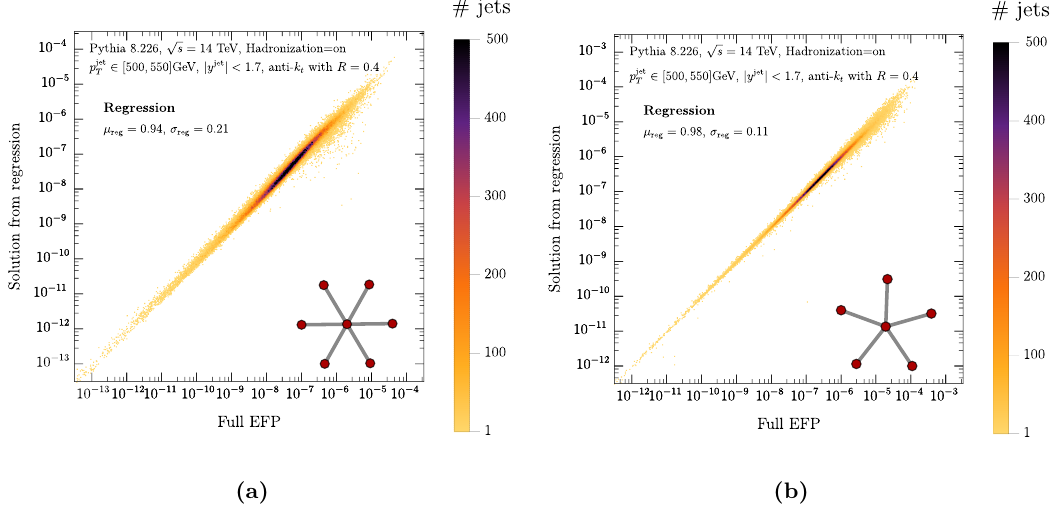
Figure 10. Testing the relationship between the 6-pointed (left) and 5-pointed (right) star EFP and a corresponding linear fit of EFPs belonging to the 2-collinear basis. The average and standard deviation of the ratio is greatly improved over that for the relationship obtained using 2-collinear power counting, which was ( µ, σ ) = (4 . 89 , 3 . 86) and ( µ, σ ) = (2 . 42 , 1 . 31) , 6 5